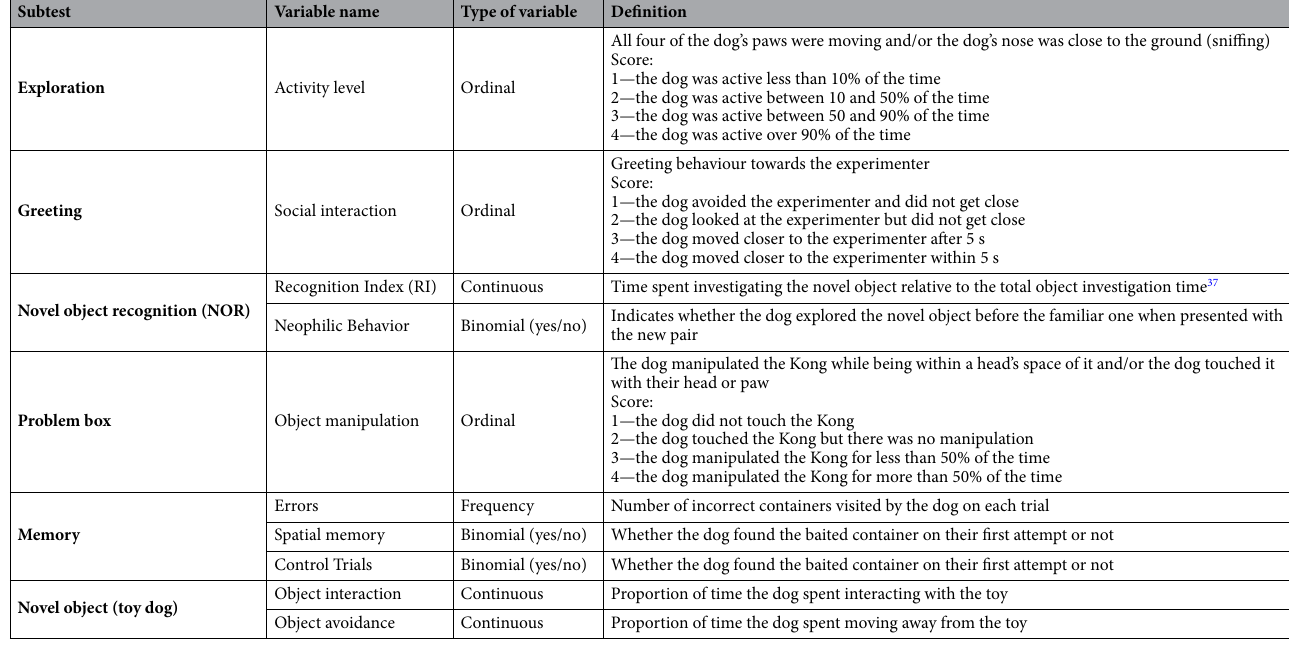
Table 1. Subtests of the battery, variables, and their definition (modified from Kubinyi and Iotchev,